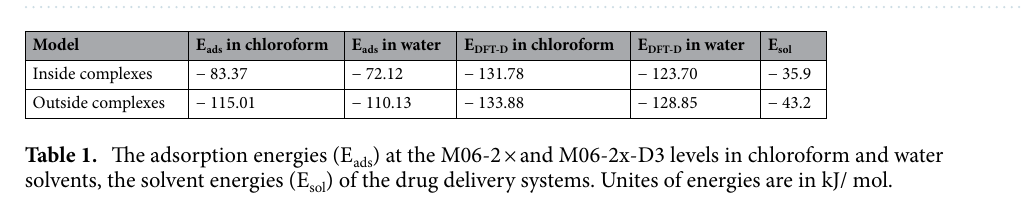
Figure 1. The optimized structures of inside and outside complexes along with the interatomic interactions numbering scheme.